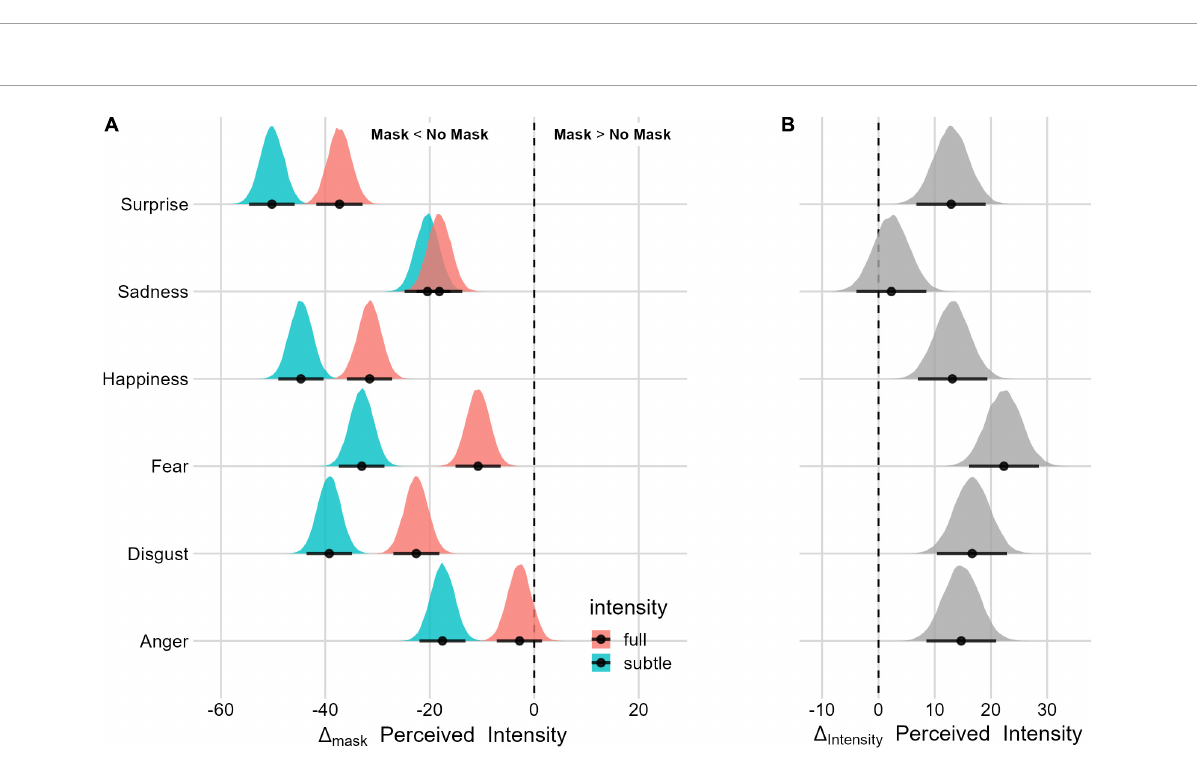
FIGURE8 Posterior distributions and 95% HPDI of the perceived intensity Facial Expression Intensity Effect (A) Perceived intensity posterior distributions as a function of the Facial Expression Intensity condition. (B) Posterior distribution of the Facial Expression Intensity (cid:49) (Mask (cid:49) full –Mask (cid:49) subtle